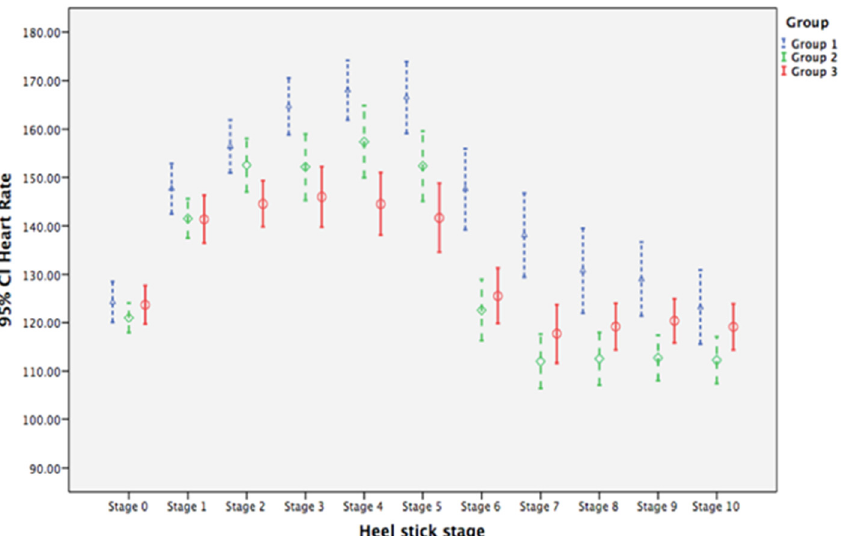
Figure 3. Clustered error-bar graph showing time trends of mean heart rates with 95% confidence intervals (CI) for neonates in the three treatment groups over heel-prick stages. Groups: 1 (blue), gentle touch plus human voice (control condition); 2 (green), control condition + breast milk odor; 3 (red), control condition + breast milk odor + breast milk taste by syringe feeding; Stage 0, baseline (no stimulation); Stages 1 to 4, the 1st to the 4th min during heel prick, respectively; Stages 5 to 10, the 1st to 6th min after completion of heel prick,